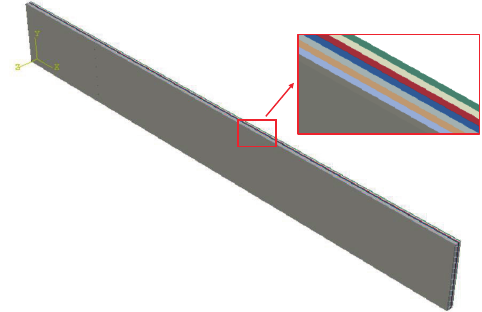
Figure 9. Macroscopical